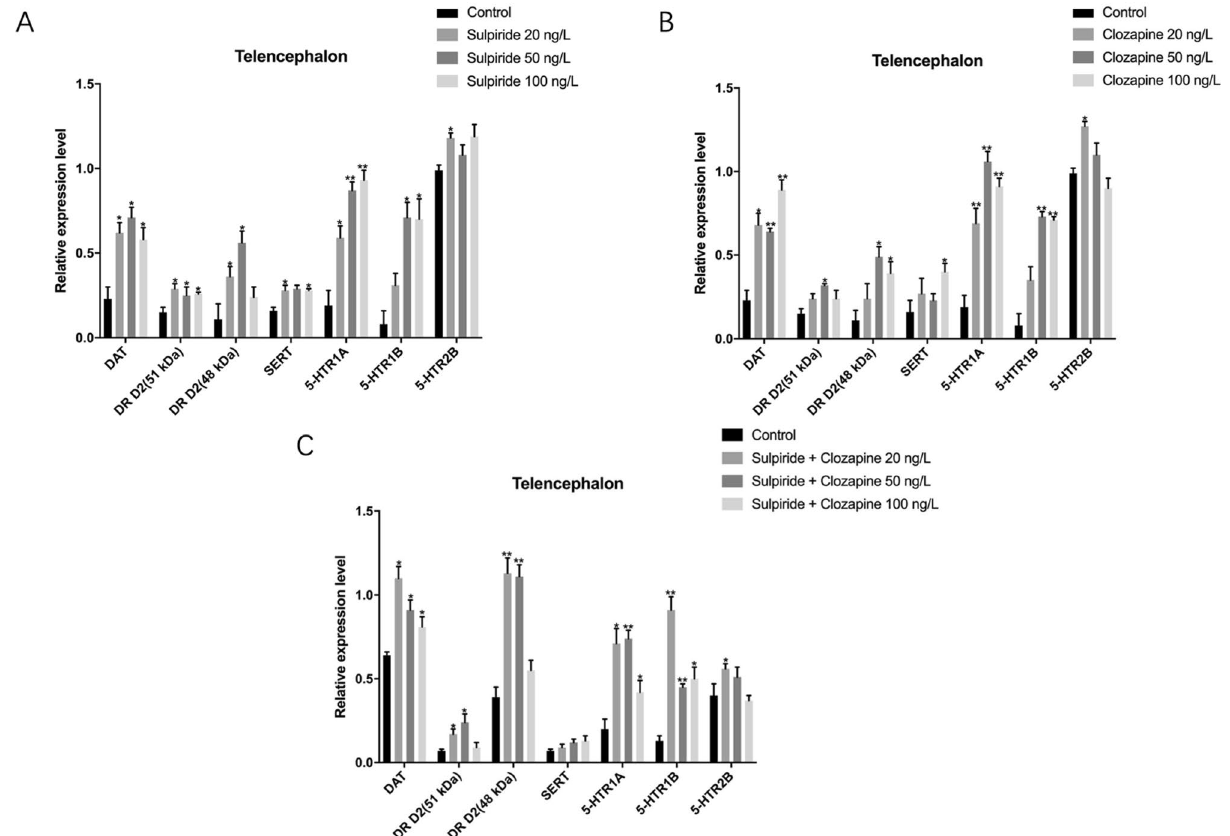
Figure 2. Changes in the protein levels of functional molecules involved in DAergic and 5-HTergic systems in zebrafish telencephalon induced by sulpiride and clozapine. Note: ( A ) Sulpiride, ( B ) Clozapine, ( C ) Mixture of sulpiride and clozapine. Data are presented as means ± SE (n = 20). p < 0.05 was considered statistically significant. * p < 0.05, ** p <